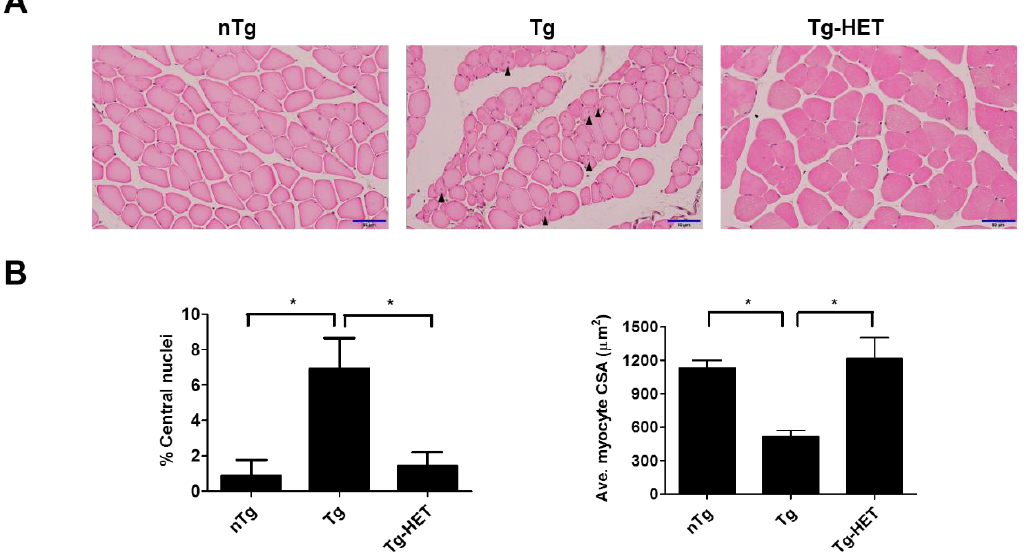
Figure 3. Hochu-ekki-to (HET) treatment has a protective e ff ect against muscle atrophy in the gastrocnemius of an ALS mouse model. ( A ) Representative images of H&E staining showing the muscle atrophy condition, such as smaller myocytes and abnormal nuclei in gastrocnemius of hSOD1 G93A mice. Arrowheads indicate abnormal nuclei (central nucleation) in myocytes. ( B ) Abnormal nuclei were expressed as a percentage of abnormal nuclei (left panel). Quantified average myocyte cross-sectional area (CSA) (right panel). Scale bar = 50 µ m Data are presented as the mean ± SEM ( n = 3 / group). * p < 0.05. nTg: non-transgenic mice, Tg: hSOD1 G93A , Tg-HET:HET-treated hSOD1 G93A